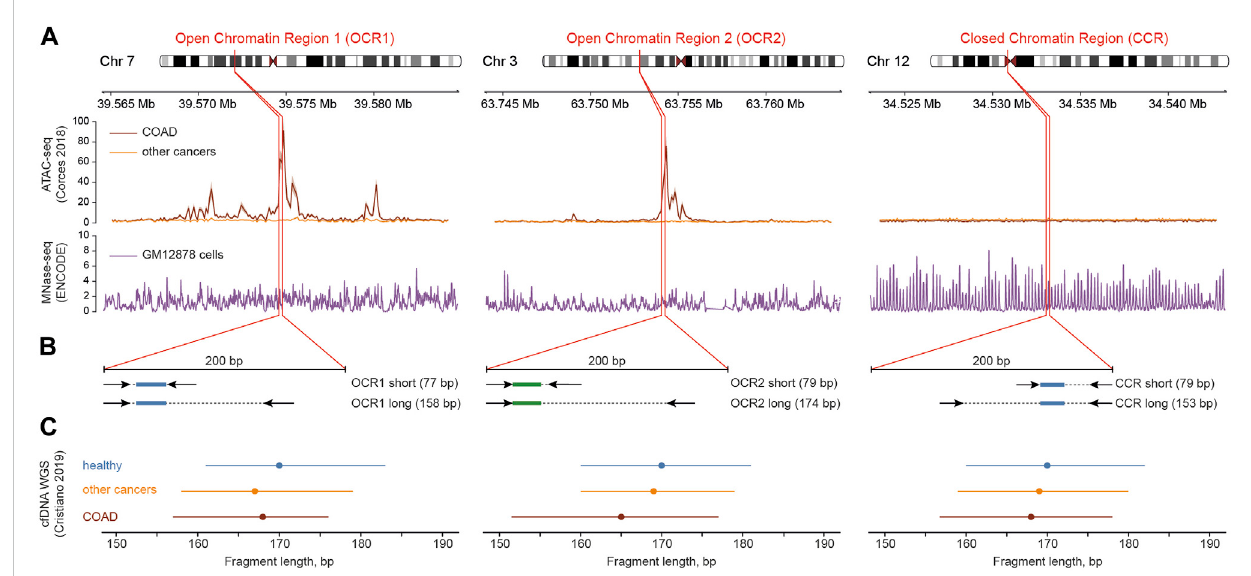
FIGURE 1 Outline ofthedesignof ddPCRsystems. (A) Chromatin state (ATAC-seq,top track)and nucleosomepositioning(MNase-seq, bottom track)context nearthestudiedgenomicregions(redborders)incancerandnormalcells.Datafrom(Bernsteinetal.,2012;Corcesetal.,2018). (B) Positioningofprimers (arrows) and probes (colored rectangles: green for labeled with HEX and bluefor labeled with FAM fl uorescent dyes) within thetargetregions. (C) Length of cfDNA fragments shown as medians (dots) and interquartile ranges (lines) derived from whole-genome sequencing data of healthy and cancer individuals (Cristiano et al.,